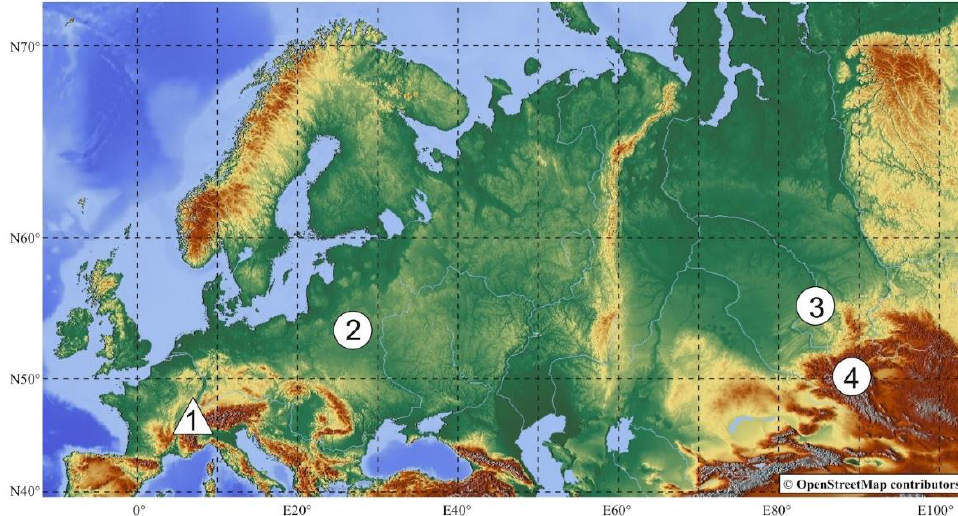
Figure 1. Geographical distribution of sampling localities of Ctenotaenia marmotae . Circles indicate samples collected by the authors; triangles indicate samples according to [11]. Locality numbers refer to Table 1.